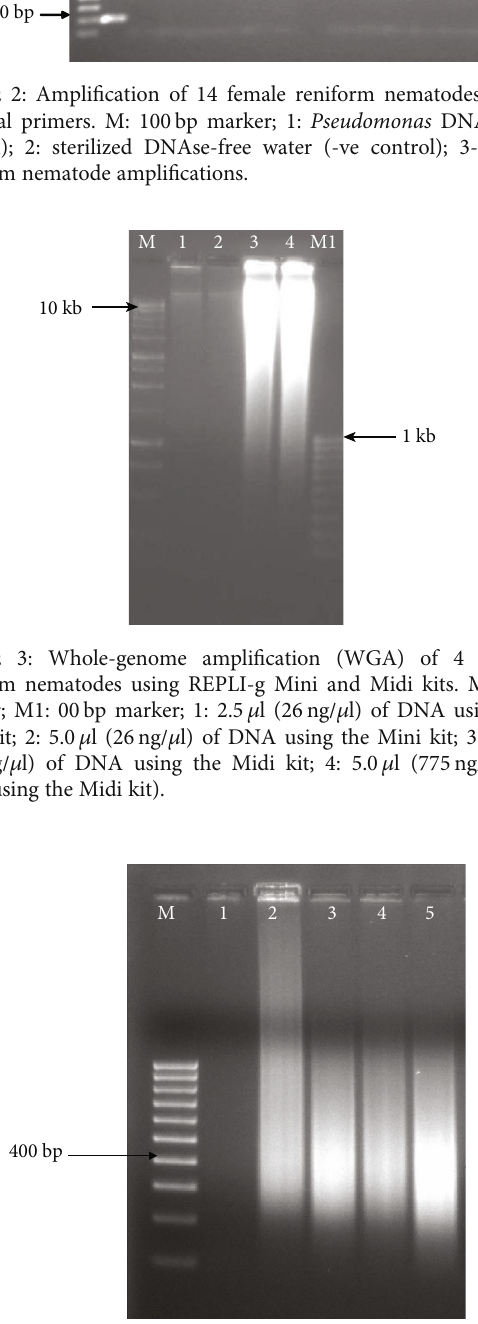
Figure 4: Whole-genome ampli fi cation (WGA) of 4 female reniform nematodes using SIGMA kit. M: 100 bp marker; 1: -ve control (no DNA); 2: +ve control (human genomic DNA_D7192)- 45ng/ μ l; 3: RN DNA sample 1A (143ng/ μ l), 4: RN DNA sample 12A (145ng/ μ l); 5: RN DNA sample 13A (134ng/ μ l).